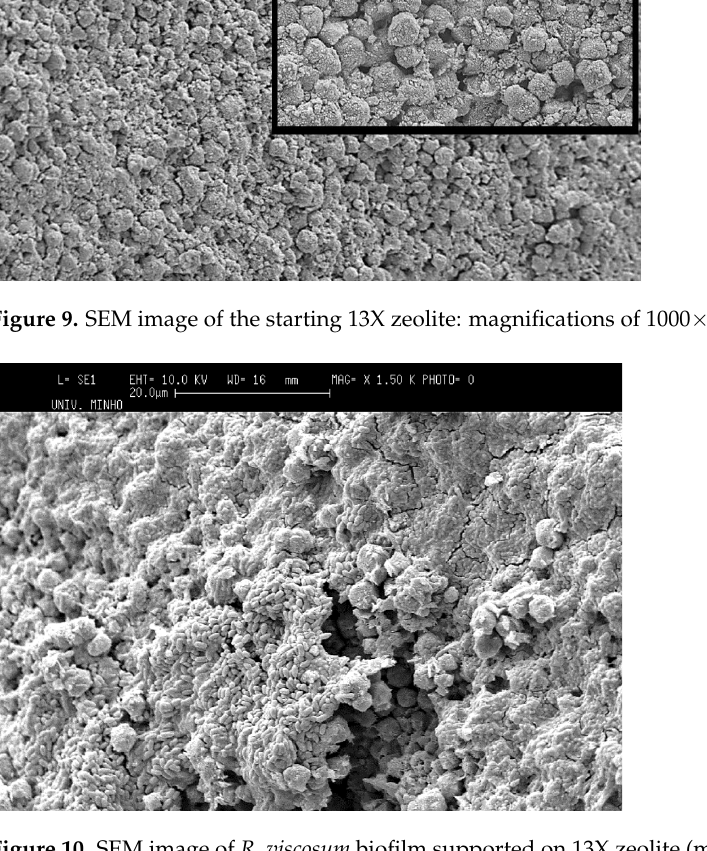
Figure 10. SEM image of R. viscosum biofilm supported on 13X zeolite (magnification of